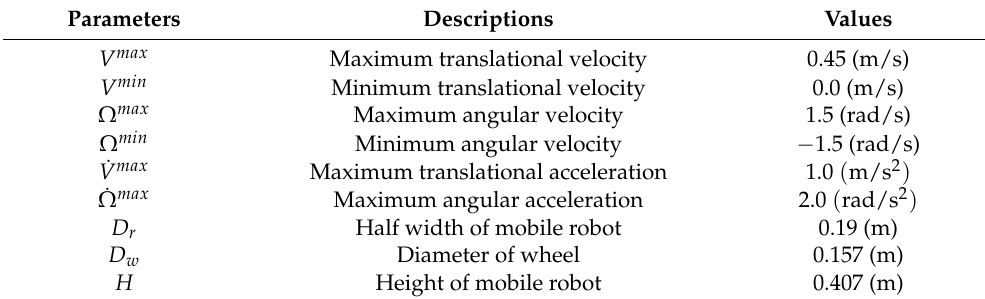
Table 1. Specifications of mobile robot.